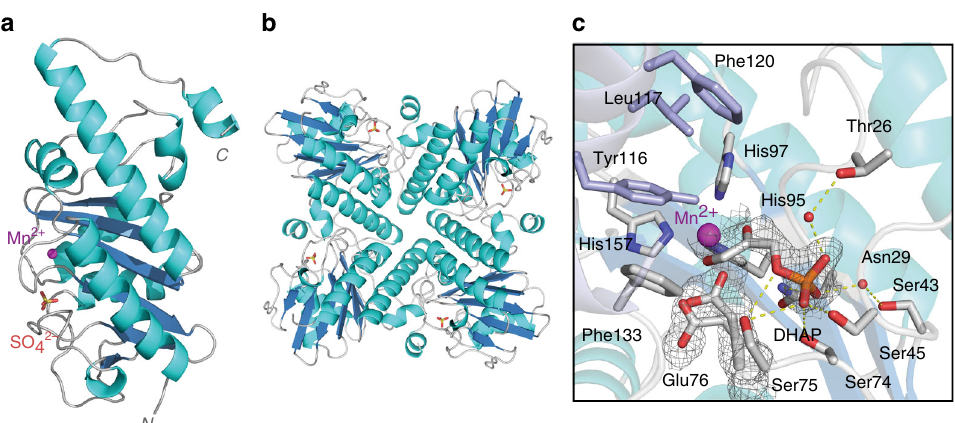
Fig. 4 Structural basis for the 5 ′ -deoxyadenosine pathway aldolase, DrdA. a X-ray crystal structure of DrdA (monomer) shown in ribbon representation with the active site manganese ion (purple) and sulfate anion (red) illustrated. b Structural representation of the tetrameric biological unit of the aldolase; the illustrated sulfate anion de fi nes the active site. c View of the active site, illustrating amino acid side chains around the manganese ion. An electron density map is shown (calculated at 1.0 σ ) around the bound substrate, dihydroxyacetone phosphate (DHAP), and the two positions of Glu76 in